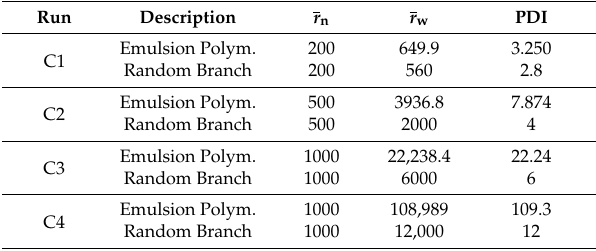
Table 5. Comparison of the calculated average chain lengths for conventional FRP.